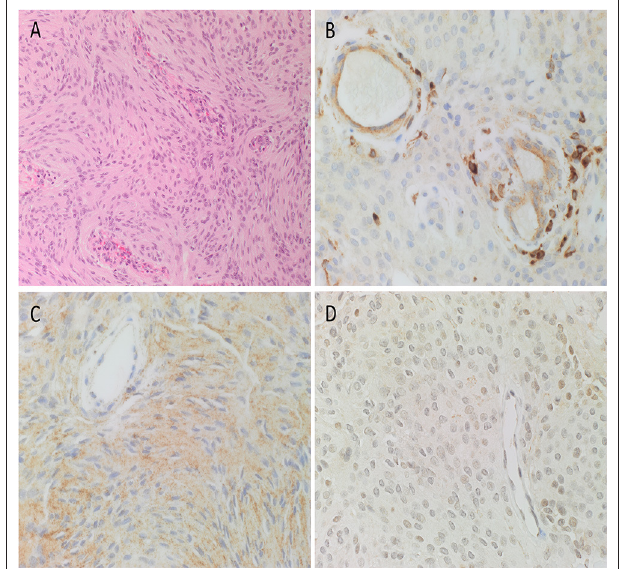
FIGURE 2 | Representative hematoxylin and eosin-stained section of a WHO grade I meningioma (MG) demonstrating the distinctive and characteristic whorls (A) . Representative 3,3-diaminobenzidine immunohistochemical-stained sections of WHO grade I MG demonstrating cytoplasmic and/or nuclear expression of cathepsins B ( B , brown), D ( C , brown), and G ( D , brown). Cell nuclei were stained with hematoxylin ( A–D , blue). Original magnification: (A) 200x; (B)